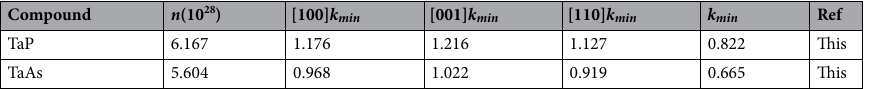
Table 9. The number of atom per mole of the compound n (m −3 ), minimum thermal conductivity k min (W/m K) of TaP and TaAs compounds along different